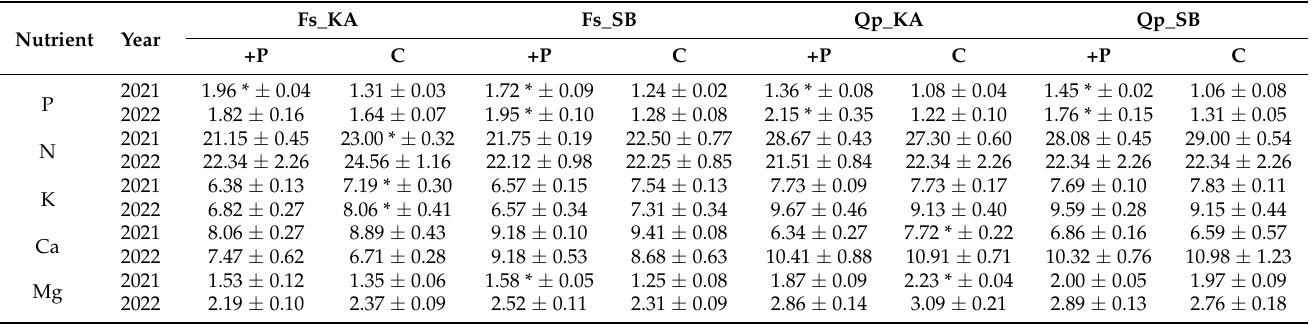
Table 3. Mean nutrient contents ± standard errors (mg g − 1 ) in dried leaf samples of the beech and oak provenances by treatment. Samples were taken in September 2021 and May